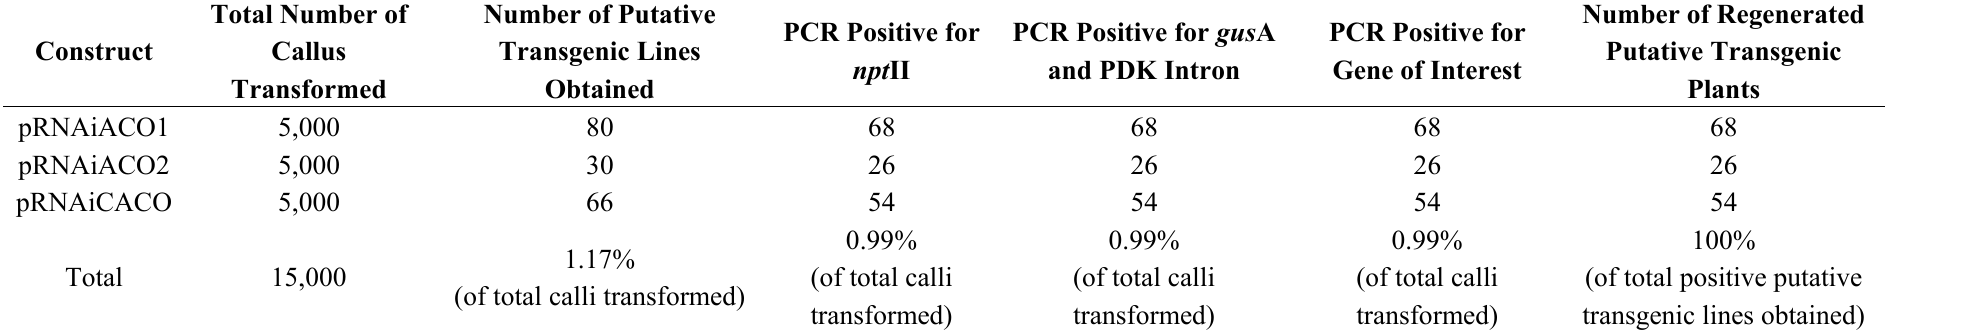
Table 1. PCR analyses of RNAi putative transgenic papaya